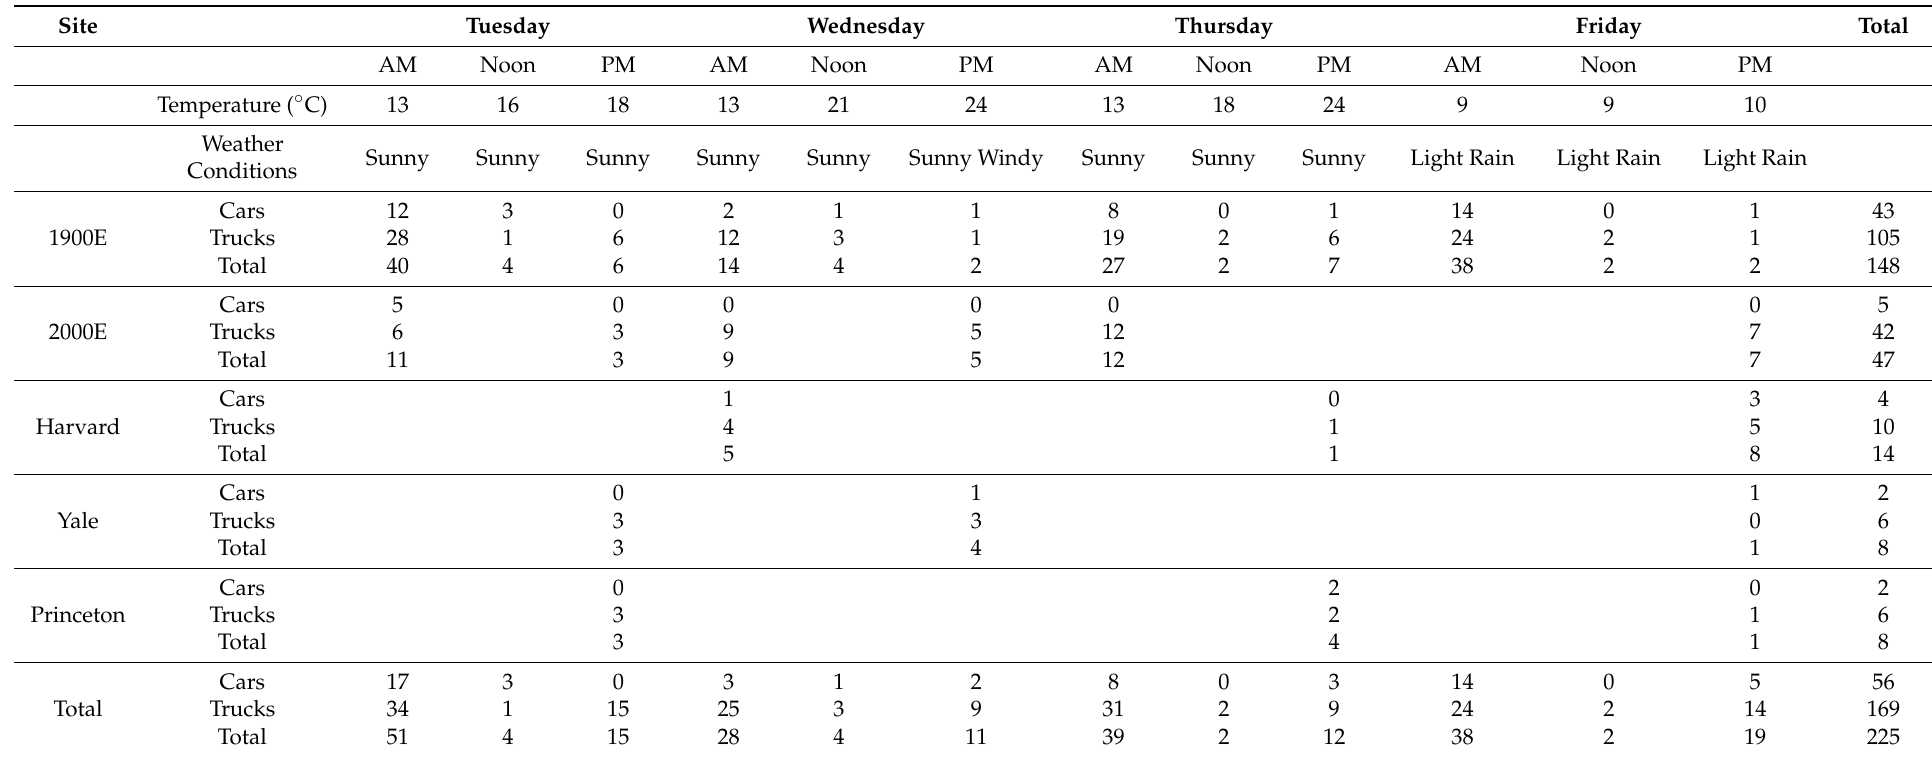
Table 6. Idling vehicle counts during the pre-intervention week: 17–20 September